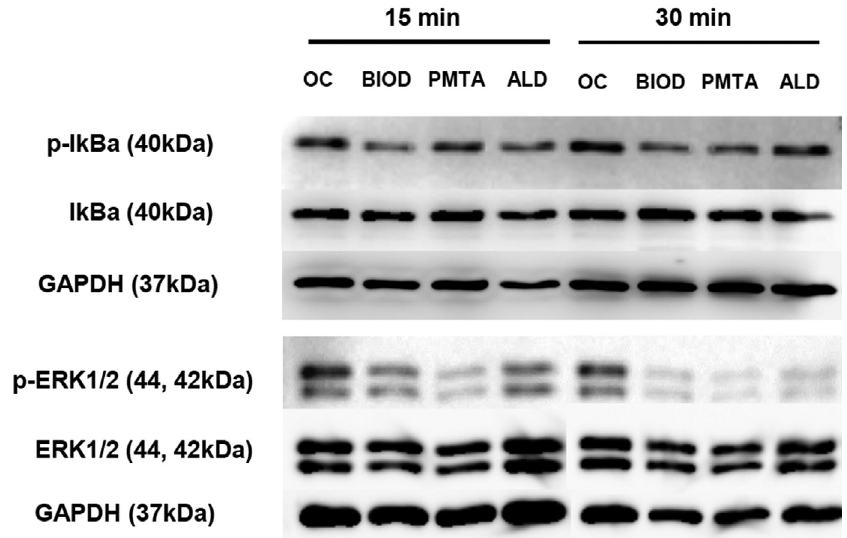
Figure 6- CSCs and ALD suppressed activation of the NF-kB pathway in RANKL/LPS-stimulated BMMs. ALD=alendronate; BIOD=Biodentine; BMMs=bone marrow macrophages; CSCs=calcium silicate-based cements; LPS=lipopolysaccharide; OCLs=osteoclasts; PMTA=ProRoot MTA; RANKL=receptor activator of